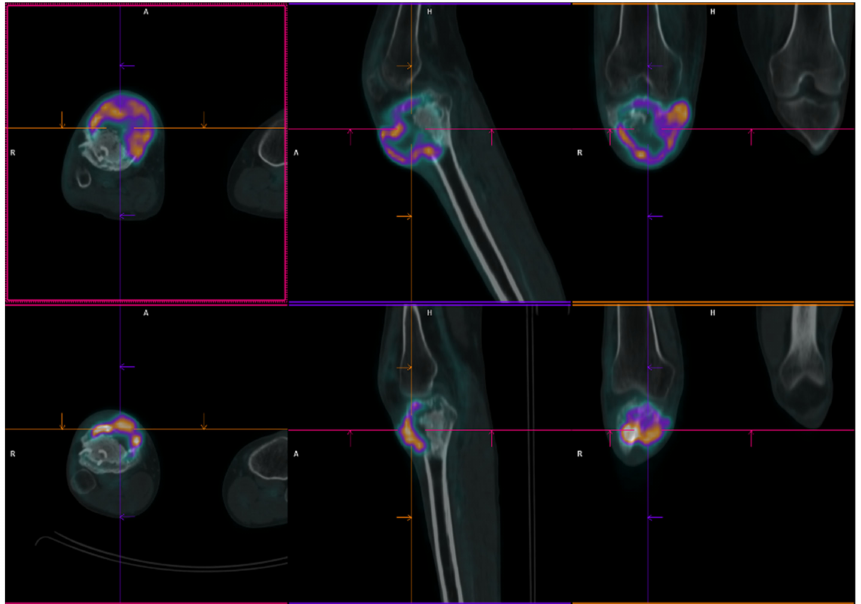
Figure 2. 18 F-FDG PET/CT axial ( left ), sagittal ( middle ) and coronal ( right ) fused view of right knee in patient no. 2. A first PET/CT scan (lower row) showed the presence of a pathological tissue with high metabolic activity (SUVmax = 26.5) at the level of the right tibia extending to the neighbouring soft-tissue compatible with relapse. A second PET/CT scan performed three months after starting treatment with denosumab (upper row), showed a significant increase in soft-tissue component of the lesion, with stability of FDG uptake. A = anterior; R = right; H =